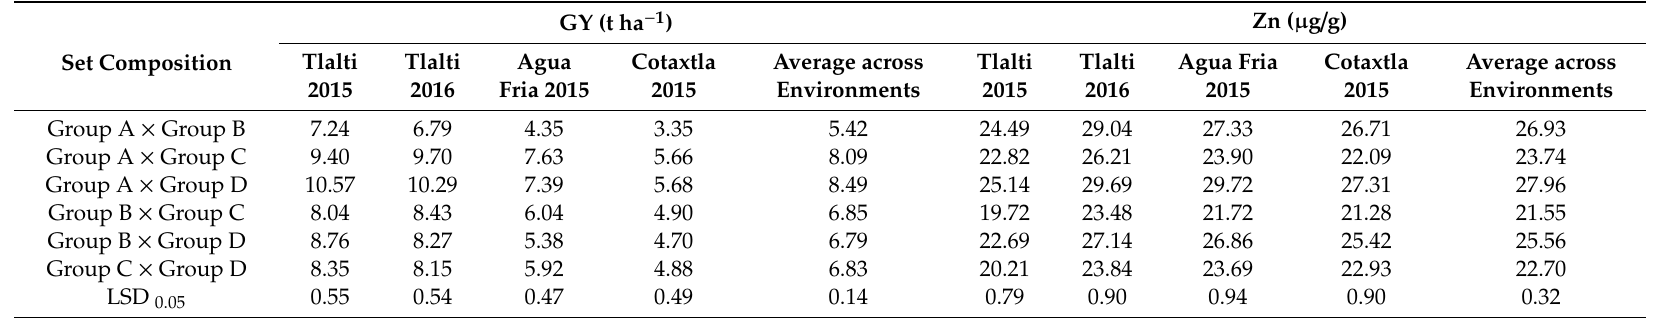
Table 4. Averages for grain yield and Zn concentration for the sets of maize